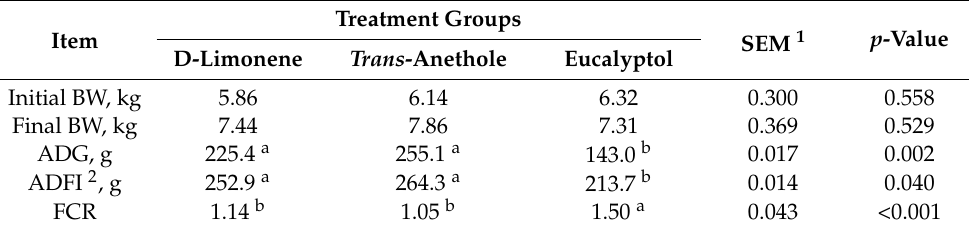
Table 4. Effects of BCs on piglet’s post-weaning performance (d 8 to d 14) within test groups of a double-choice feeding